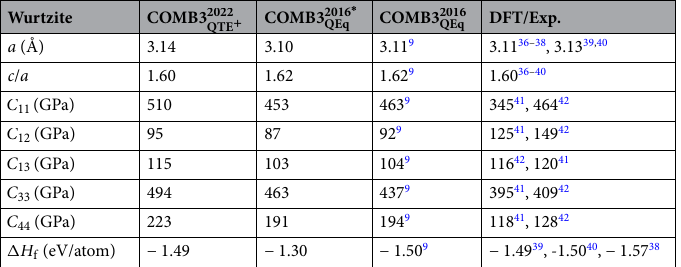
and COMB3 2016 ∗ QEq are compared to the QTE +